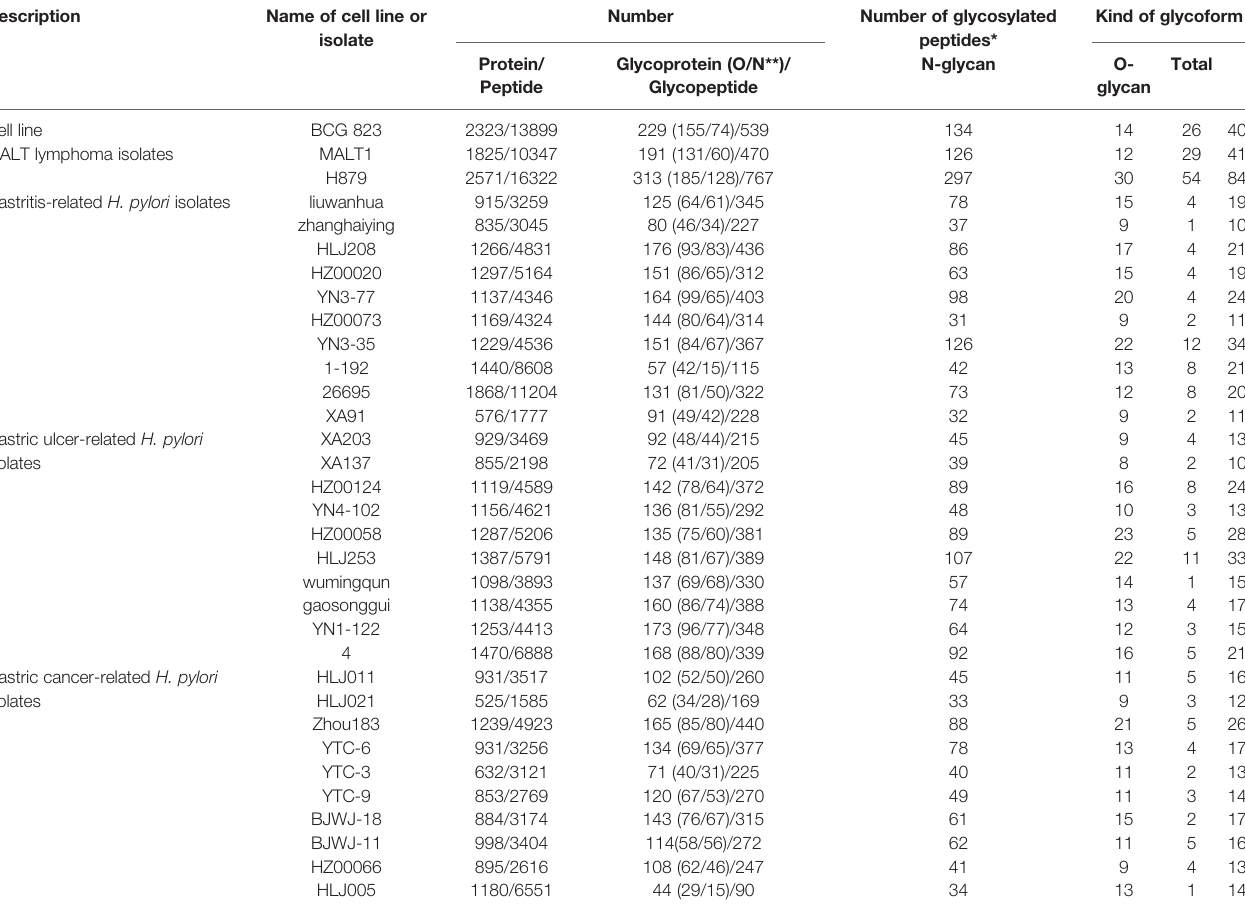
TABLE 1 | Summary of glycosylation modi fi